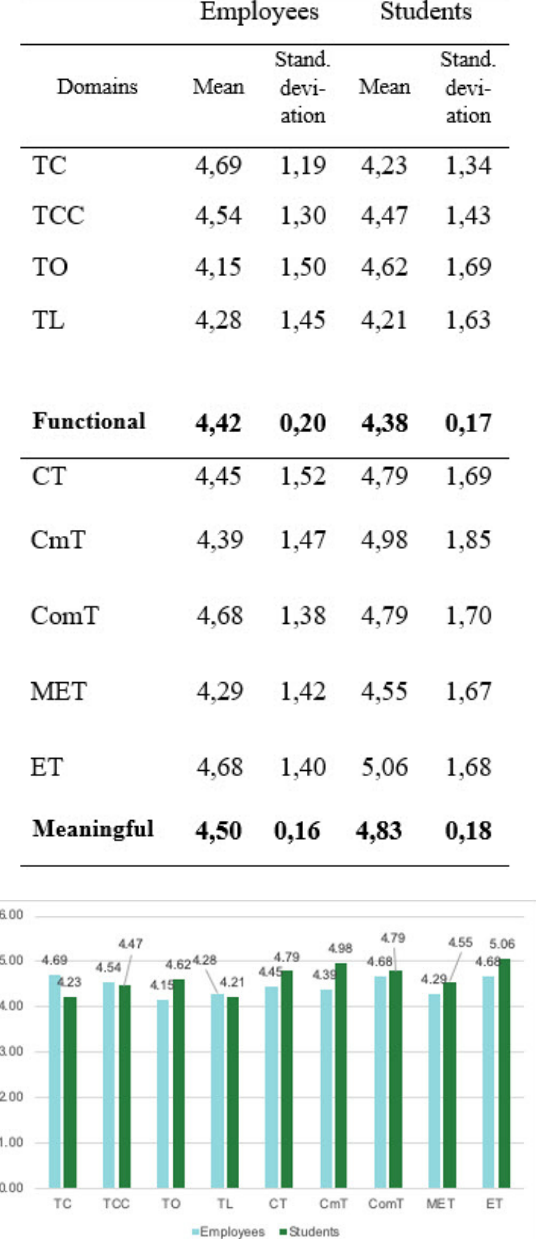
Table 4. Results of the measurement of employees’ and students’ trust in the university community of the NPDU